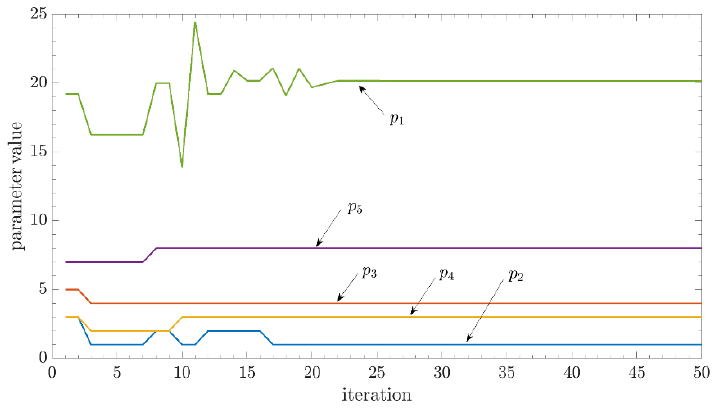
Figure 9 shows the courses of all five parameters during the iteration process. Energies 2019 , 12 , x FOR PEER REVIEW